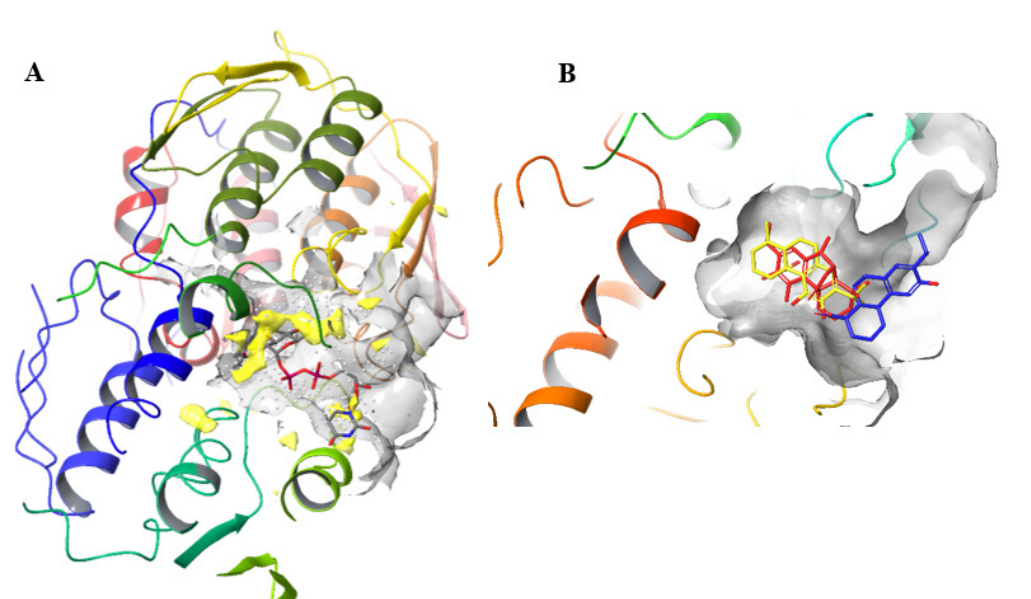
Figure 4. ( A ) Binding mode of UDP ‐ GlcNAc. Hydrophobic areas of binding cavities are colored as yellow solid; ( B ) Differences in the binding modes of the active compounds 1 (colored red) and 4 (colored yellow) and of the inactive compound 10 (colored blue).